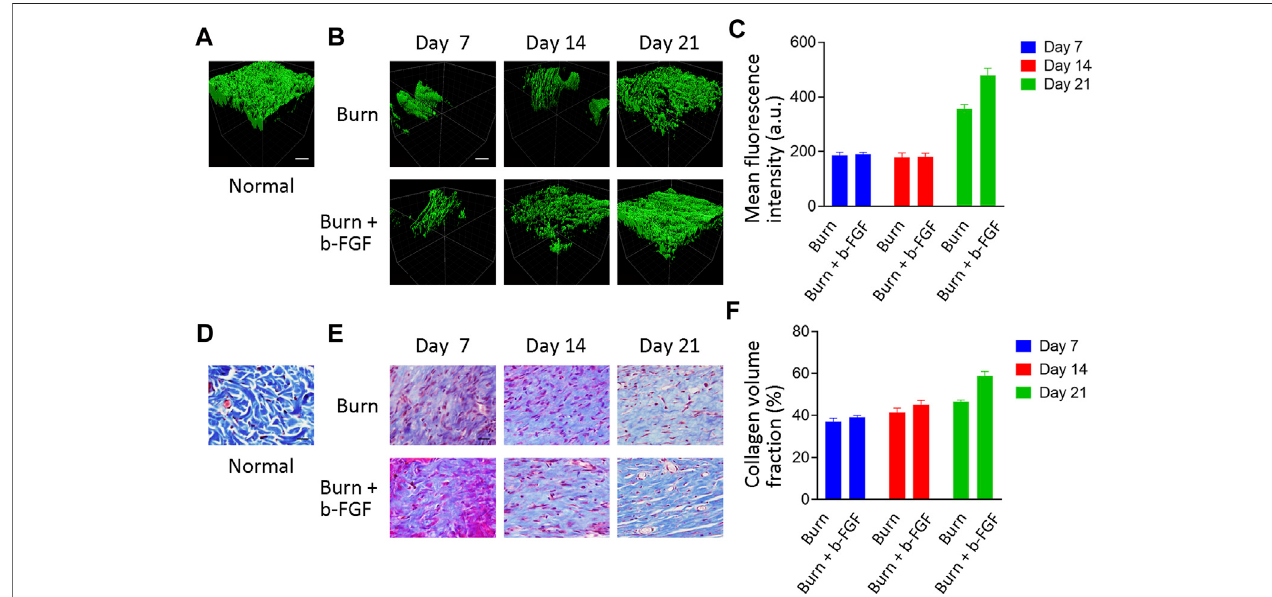
FIGURE 4 | Collagen production assessment of the deep burns by TPM and Masson staining in mice. (A) 3D reconstructions of collagen were generated using Imaris software in normal skin. Scale bar = 30 μ m. (B) 3D reconstructions of collagen were generated using Imaris software between the Burn group and the Burn + b-FGFgroup.Scalebar=30 μ m. (C) Mean fl uorescenceintensityofcollagenwasanalyzedfromTMPimaging. (D) CollagenimagesoftissueslicesdetectedbyMasson staining in normal skin. Scale bar = 20 μ m. (E) Collagen images of tissue slices detected by Masson staining between the Burn group and the Burn + b-FGF group. Scale bar = 20 μ m. (F) CVF was analyzed from Masson staining.